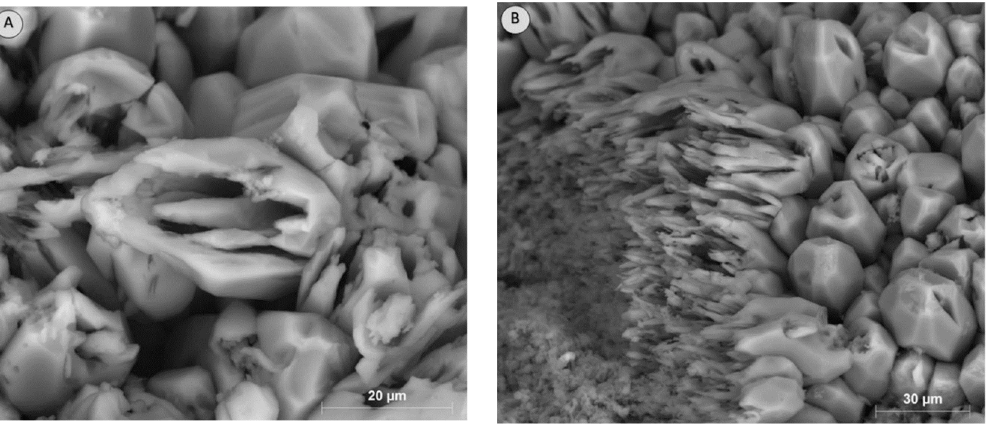
Figure 3. Calcite grain roughness alteration ( A ) and ( B ) after CO 2 brine injection